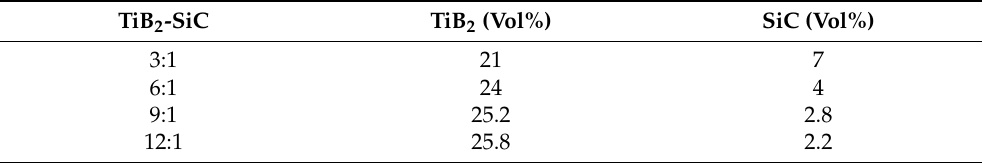
Table 1. Theoretical volume ratios of TiB 2 and SiC.